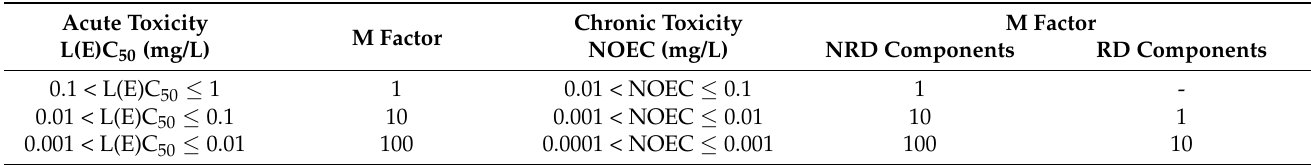
Table 5. M factors for highly toxic components